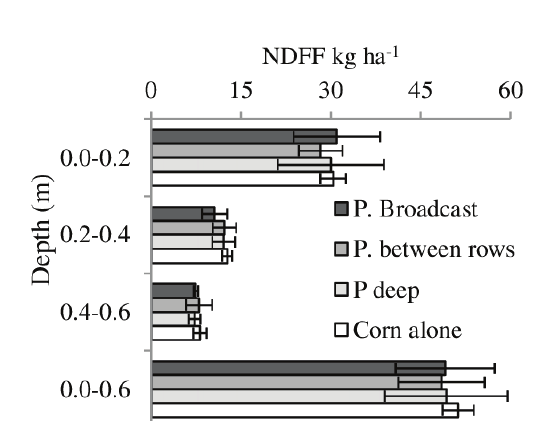
Figure 4 - Distribution of NDFF in soil depths at corn harvest. The bars represented the standard error of the